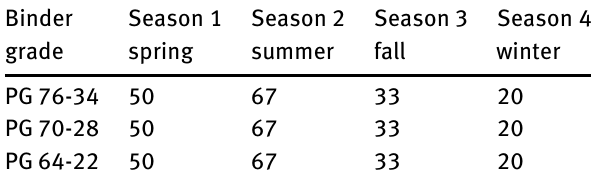
Table 5: Variation of binder grade in asphaltic overlayment rail track.